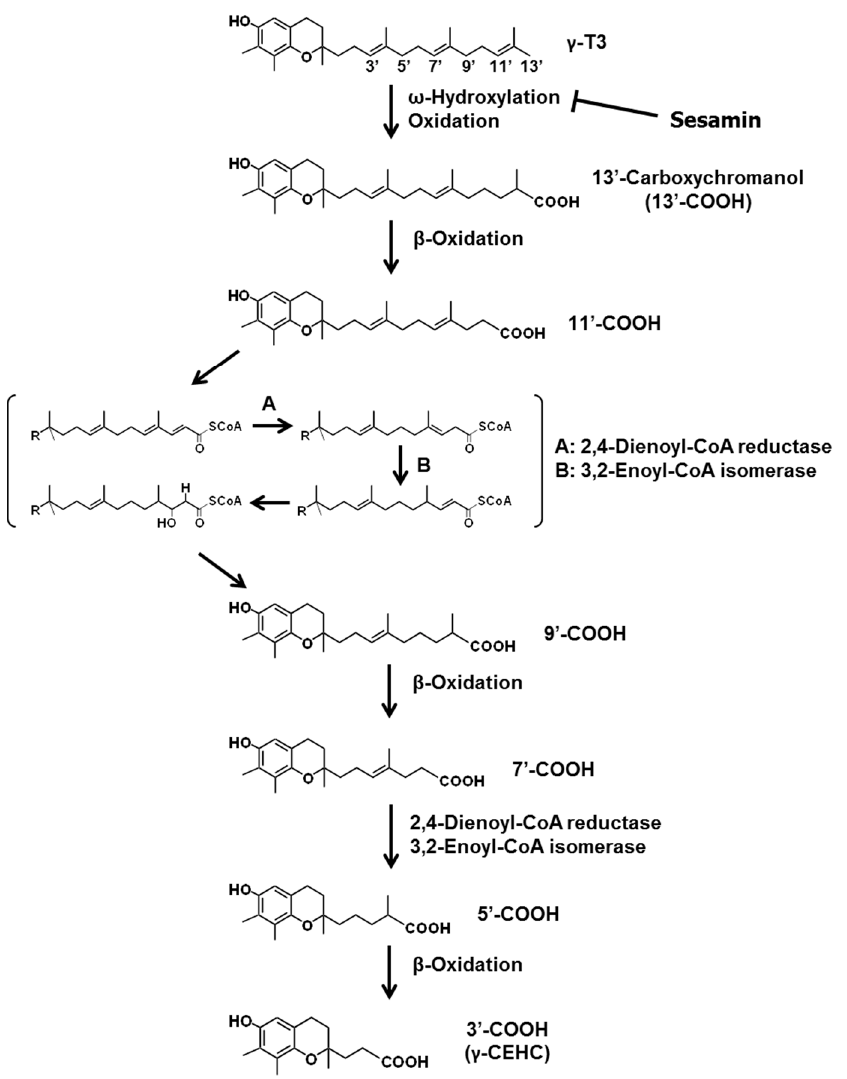
Figure 5. Metabolic pathway of γ -T3. The second and fourth cycles of β -oxidation are needed for 2,4-dienoyl-CoA reductase (A) and 3,2-enoyl-CoA isomerase (B). Arrows and perpendicular lines indicate activation/induction and inhibition/suppression, respectively.